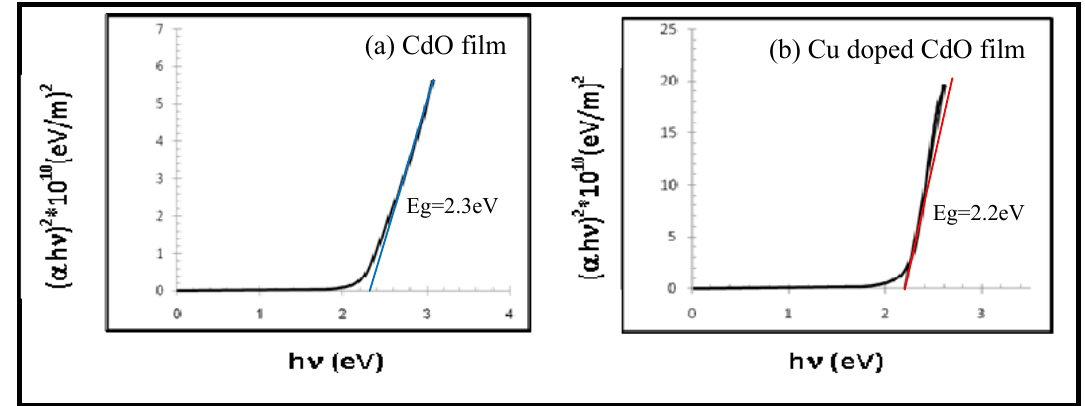
Fig. 7: The ( α h υ ) ^2 as a function of Photon energy (h υ ) of (a)CdO and (b) CdO